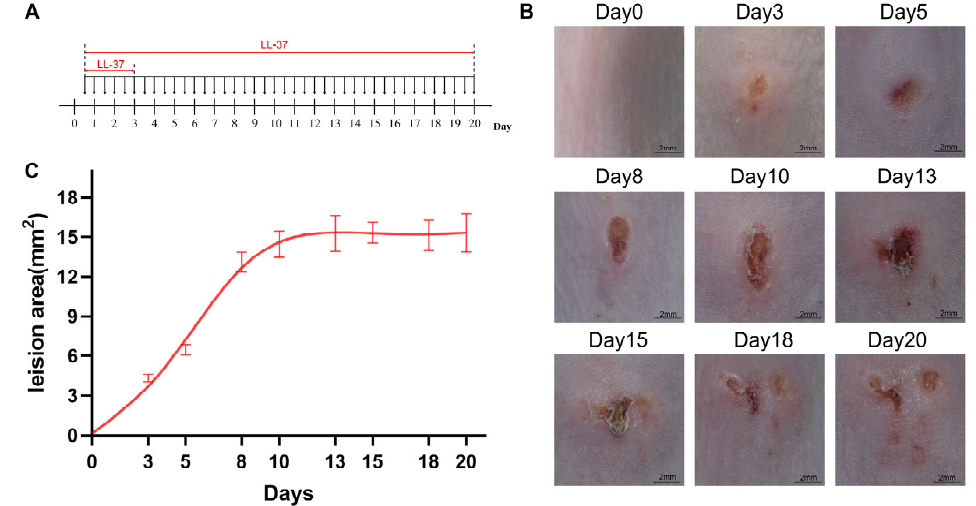
Figure 1. ( A ) The long-term LL-37 administration group received intradermal injections of LL-37 every 12 h before being euthanized on days 0, 3, and 20. ( B ) Mouse lesion area and erythema changes over time induced by LL-37 intradermal injections on days 0, 3, 5, 8, 10, 13, 15, 18, and 20 (scale bar = 2 mm). ( C ) Trend plot of lesion area. With the increase in the number of LL-37 injections, the area of erythema first expanded and then stabilized. Data are presented as the mean ± SD; n = 5 for each group.